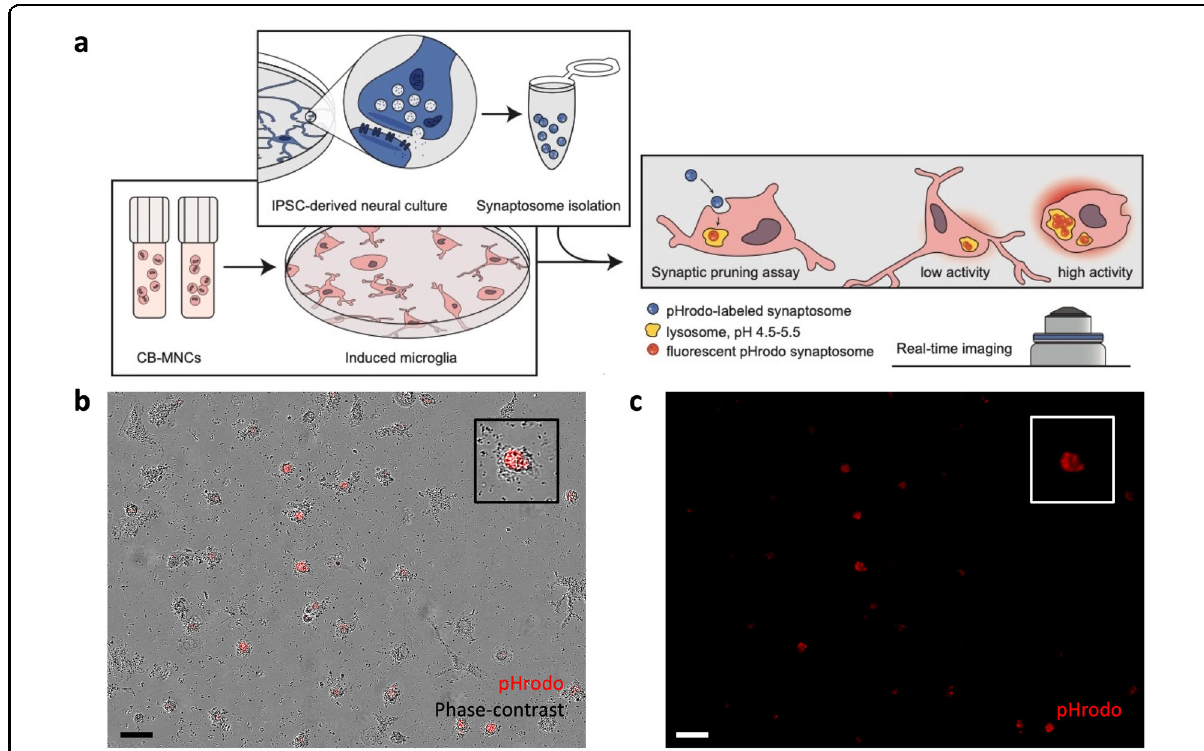
Fig. 2 Characterizing synaptosome engulfment by CB-iMGs in an in vitro model of synaptic pruning. a Overall schematic of pHrodo-labeled quantitative synaptosome phagocytosis assay by CB-iMGs. b Representative live real-time images in phase contrast/red fl uorescence overlay mode showing cellular uptake and c red fl uorescence channel alone of pHrodo (red)-labeled synaptosomes uptake at the end of the phagocytosis assay (315min). Scale bar: 60 μ m (boxes show magni fi ed view of engul fi ng